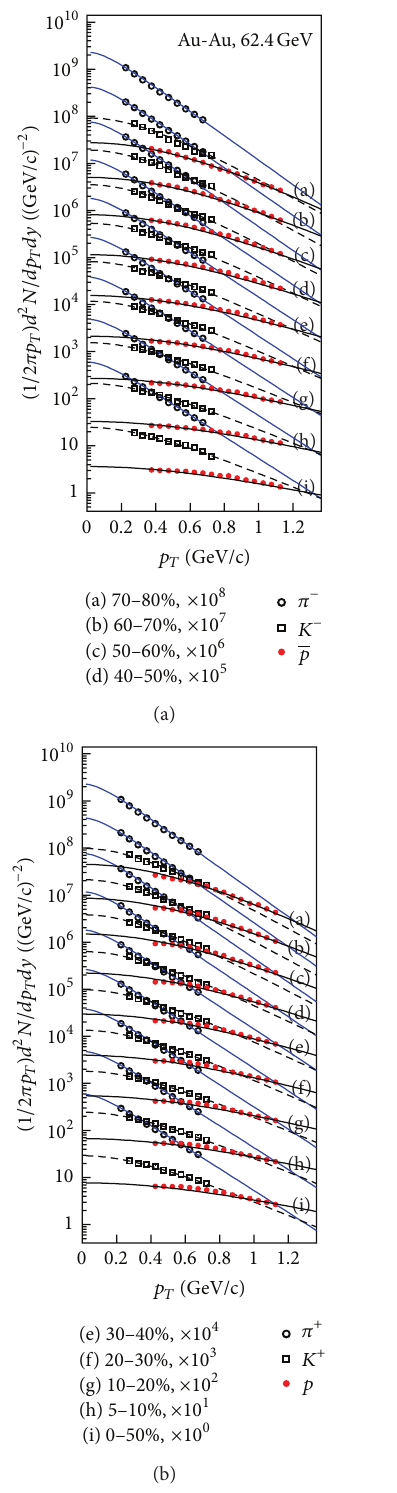
Figure5:Thetransversemomentumdistributionsof(a) 𝜋 − , 𝐾 − ,and 𝑝 , and (b) 𝜋 + , 𝐾 + , and 𝑝 produced in Au-Au collisions at √ 𝑠 62.4 GeV with different centrality classes and magnifications are shown in the figure. The symbols represent the experimental data of the STAR Collaboration [26] and the curves are our results calcu- lated by the Boltzmann or two-component Boltzmann distribution.